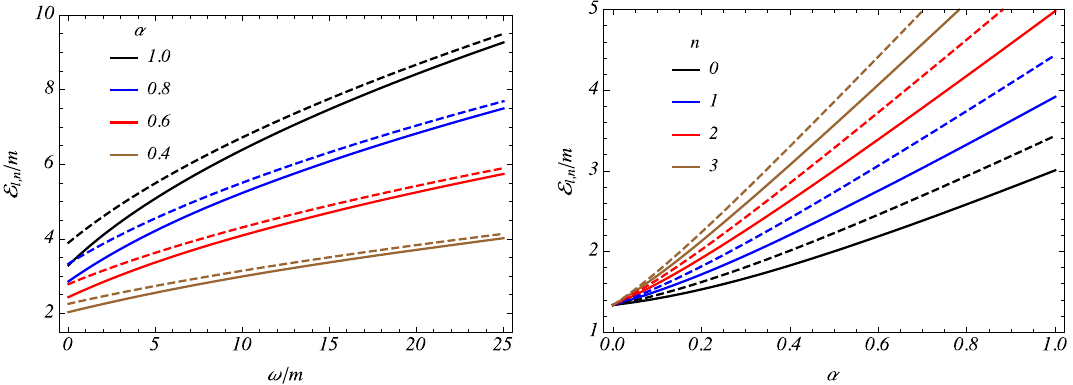
Fig. 6 PositiveenergyprofilesoftheKGOsubjecttoahardwallpoten- tial. In the left plot we have the energy as function of ω/ m considering different values of the parameter α . The right plot represents the energy as function of the parameter α for different energy levels and ω/ m .